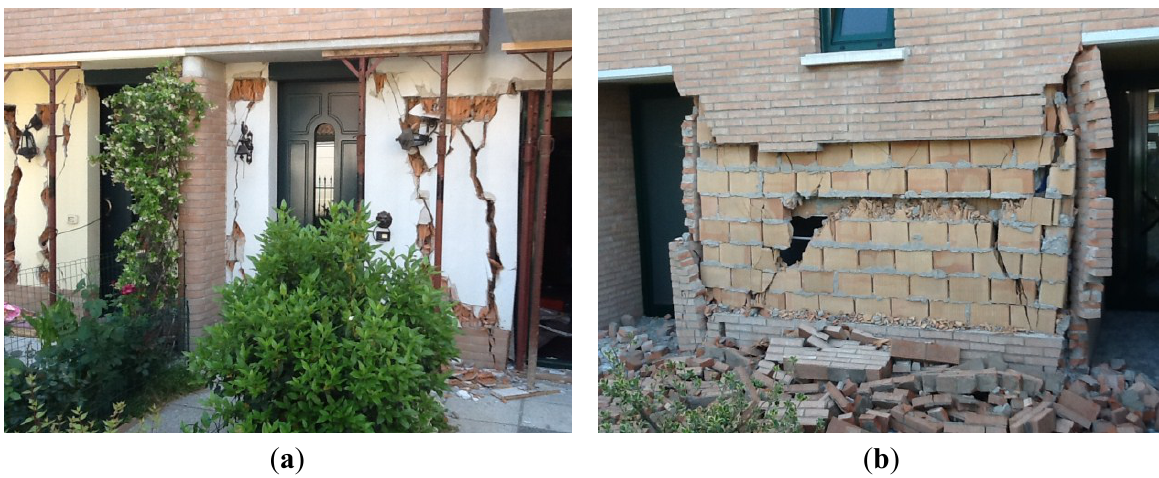
Figure 19. Heavy damage to hollow brick masonry piers: ( a ) Large sub-vertical cracks; ( b ) Ejection of external leaf and diagonal shear cracks in hollow brick masonry core.